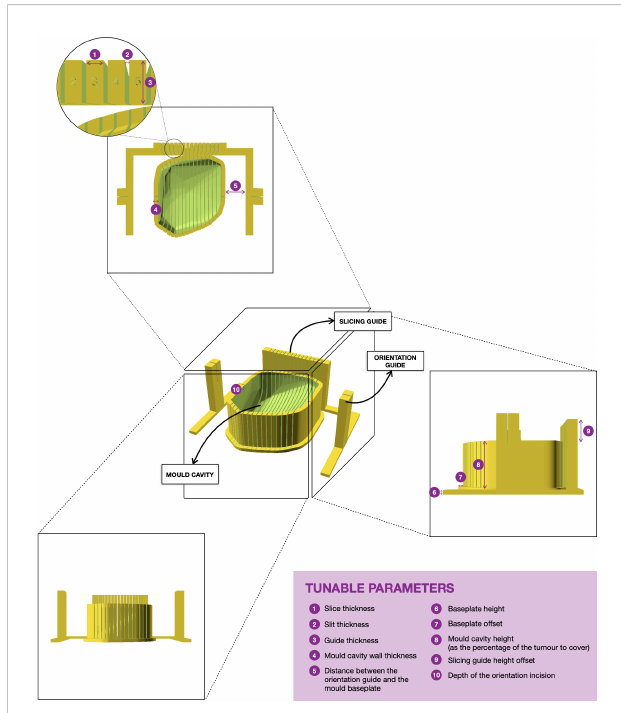
FIGURE 3 3D rendering of the fi nal version of a mould. The tumour sits on the mould cavity and it is sliced by passing a knife through each of the slits of the slicing guide. Two single-slit guide walls are built parallel to the slicing direction for the slitting of the orientation line at the top of the specimen. The orientation guide determines the position of the orientation incision, which facilitates the correct orientation of the slices when removed from the mould. The mould is customisable and the tunable parameters for mould design are in purple.